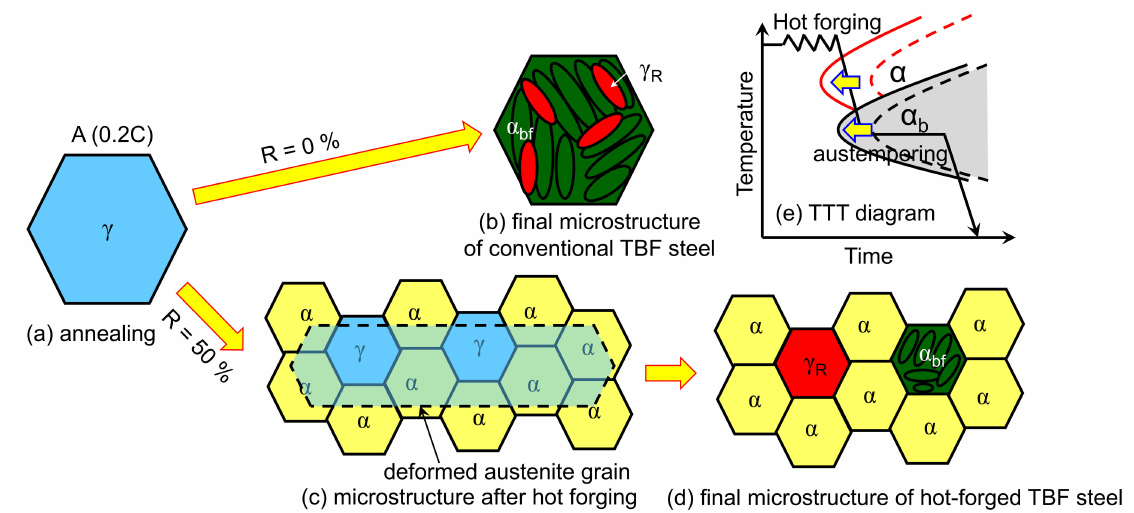
Figure 11. Illustrations of microstructure evolution behavior of hot-forged steel A. ( a ) Austenite at annealing temperature, ( b ) final microstructure of conventional TBF steel, ( c ) microstructure after hot forging, ( d ) final microstructure of hot-forged TBF steel, ( e ) TTT diagram, respectively. R represents reduction ratio. α , α b , α bf , γ , and γ R denote ferrite, bainite, bainitic ferrite, austenite, and retained austenite, respectively. The TTT diagram ( e ) is the time transition temperature